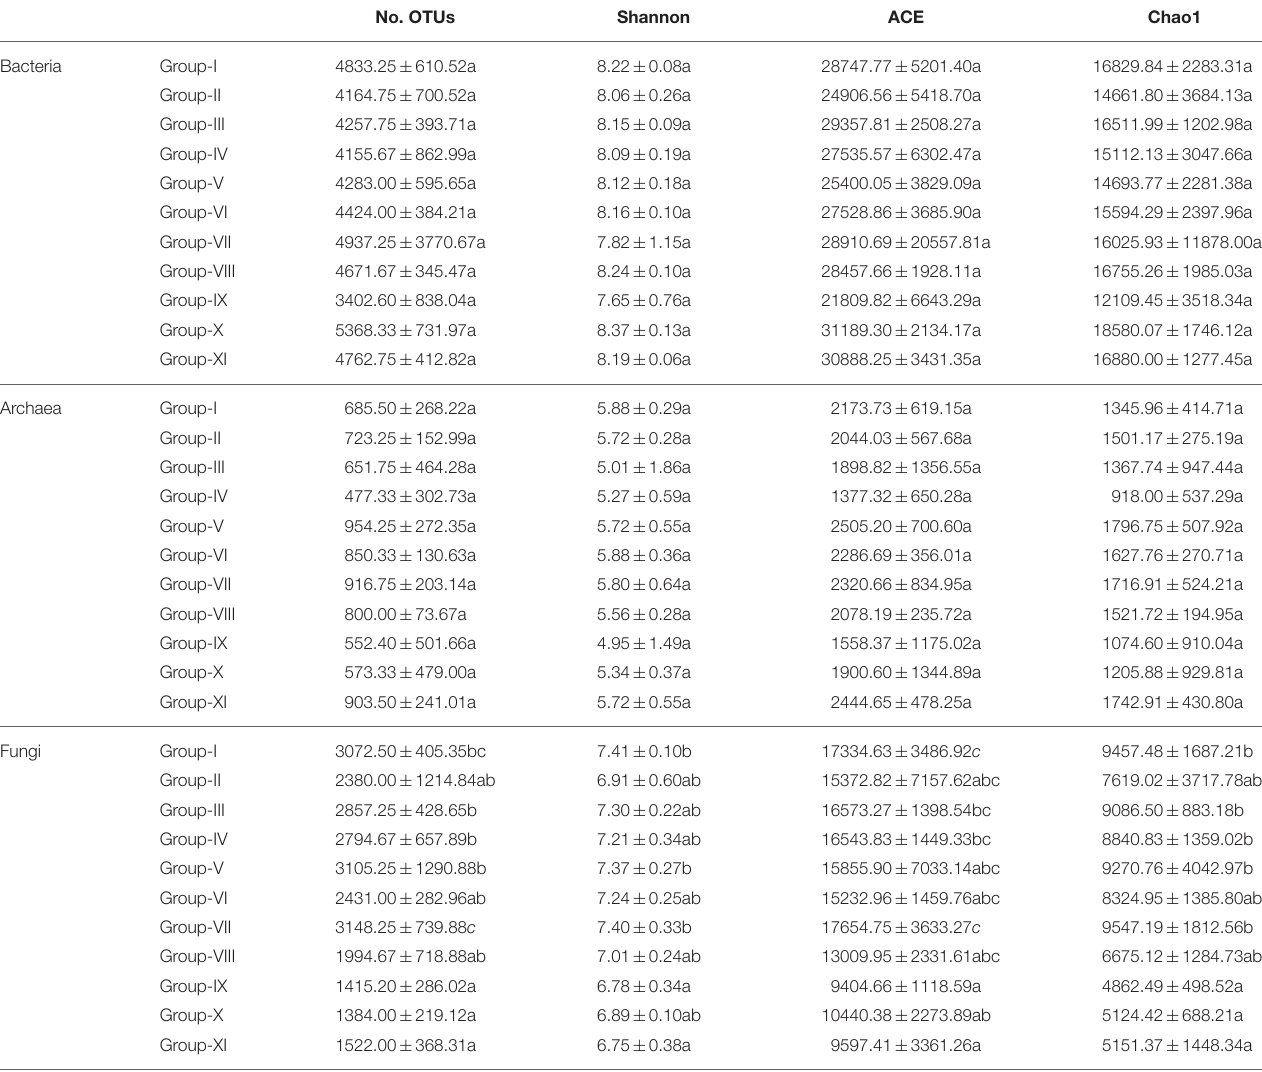
TABLE 2 | Soil bacterial, archaeal and fungal diversity indices in the reclaimed mining area. No. OTUs Shannon ACE